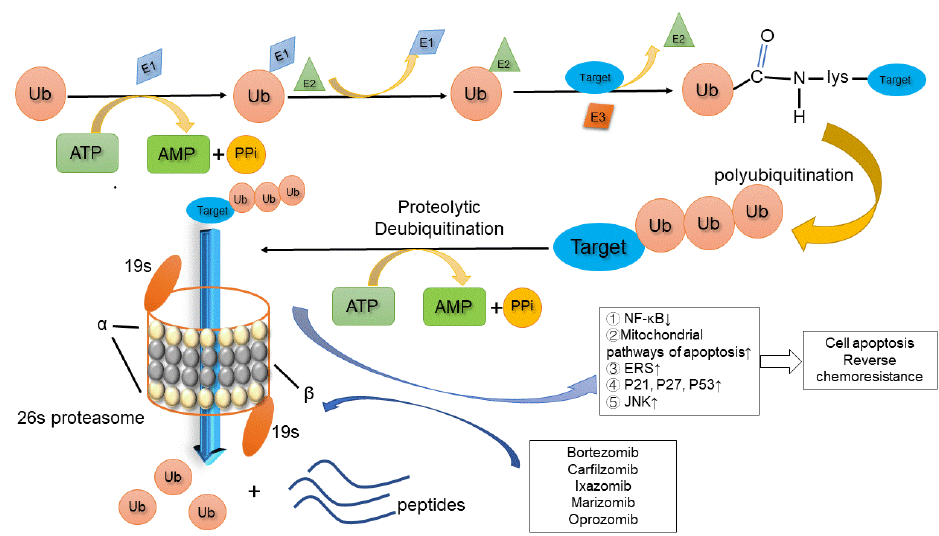
Figure 1. The target protein is ubiquitinated and transported to the 26S proteasome for degradation. Proteasome inhibitors bind to the β subunit of the catalytic core, thereby inhibiting the degradation of antitumor-related protein products. E1: ubiquitin-activating enzyme; E2: ubiquitin-binding enzyme; E3: ubiquitin-linker enzyme; Ub: